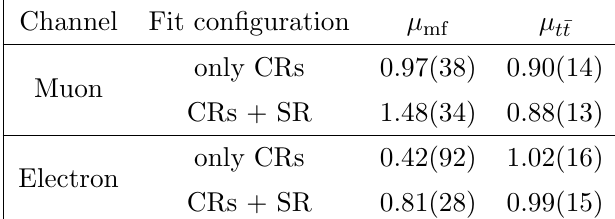
Table 4. Normalisation factors obtained for multi-fake (cid:22) mf and t (cid:22) t (cid:22) the background-only (cid:12)t. Shown are full post-(cid:12)t uncertainties of the normalisation factors taking into account all statistical and systematic uncertainties.